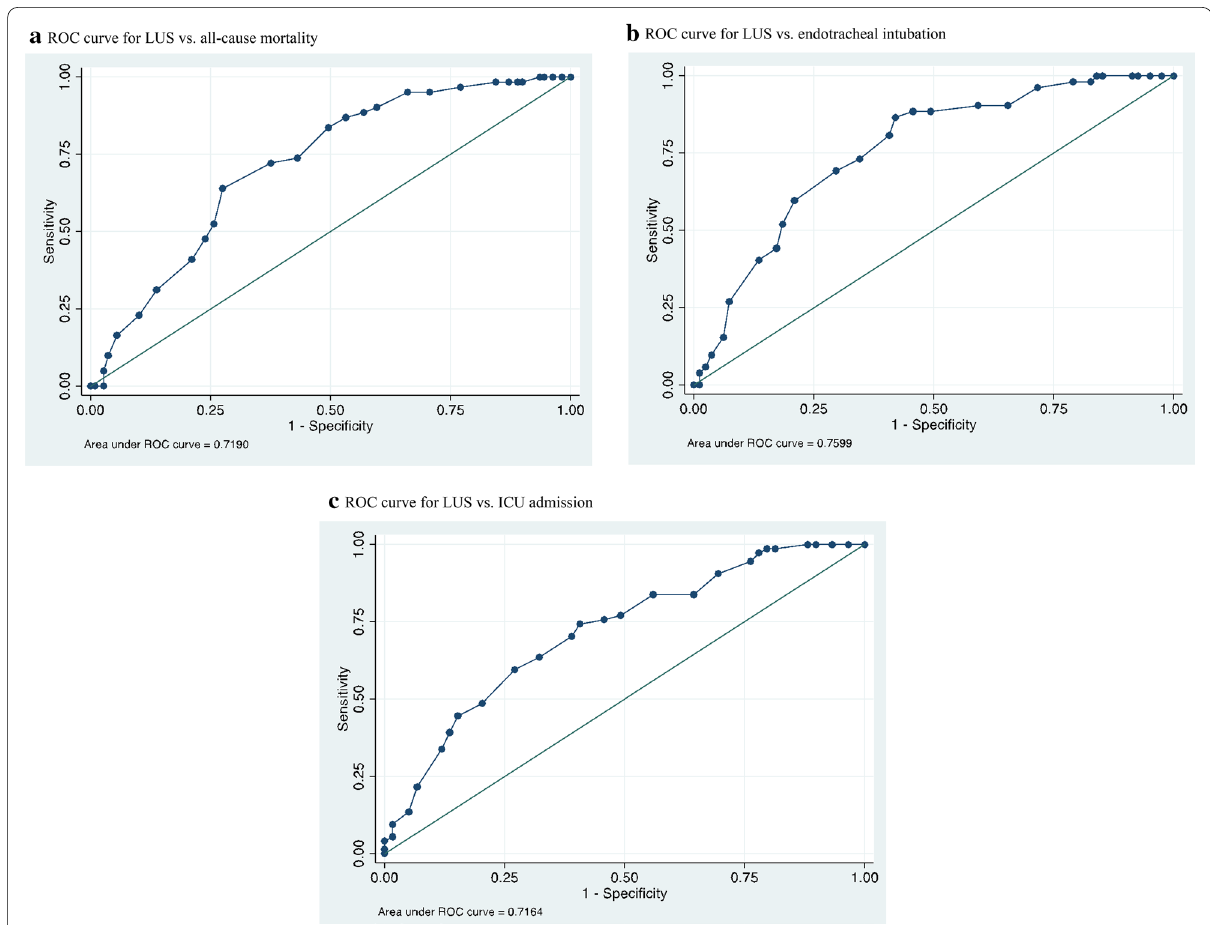
Fig. 2 ROC Curves and Outcomes. a For LUS versus all-cause mortality. b For LUS versus endotracheal intubation. c For LUS versus ICU admission